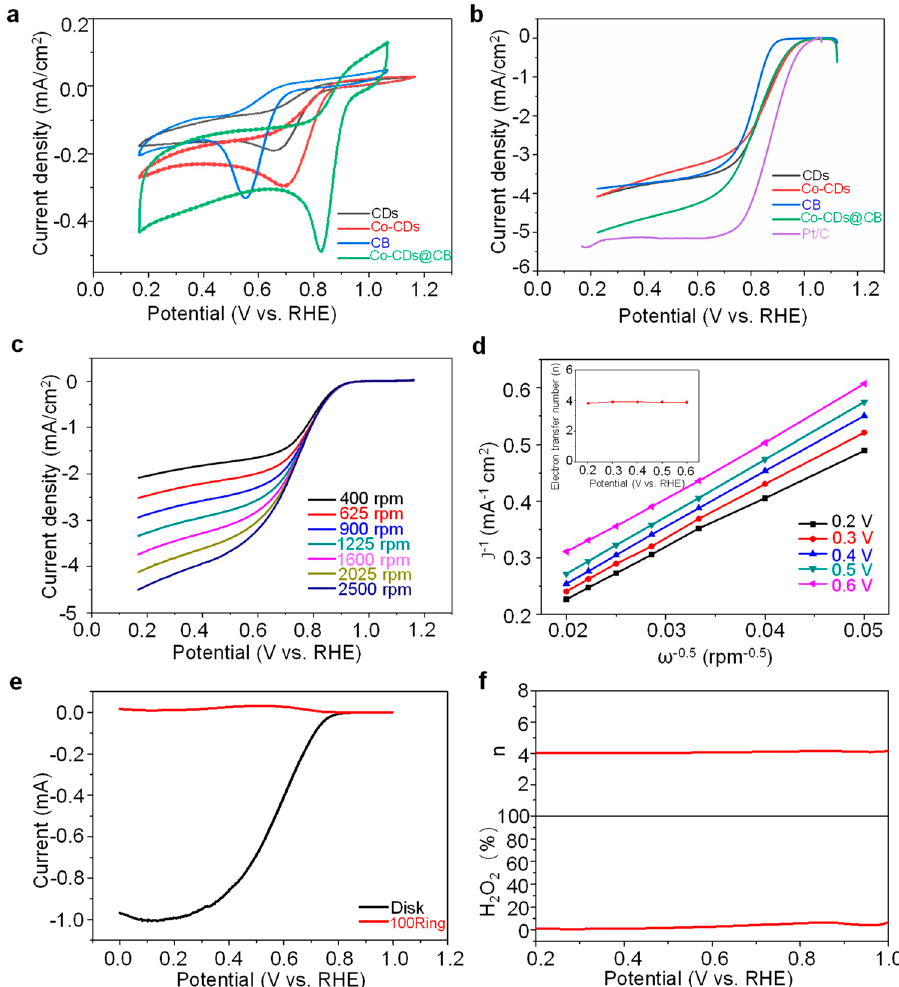
Figure 3. ( a ) CV curves of CDs, Co-CDs, CB, and Co-CDs@CB in O 2 -saturated 0.1 M KOH solution. ( b ) Polarization curves of CDs, Co-CDs, CB, Co-CDs@CB, and Pt/C in O 2 -saturated 0.1 M KOH solution at a rotating rate of 1600 rpm. ( c ) Polarization curves of Co-CDs@CB at different rotation rates. ( d ) K–L plots of Co-CDs@CB (inset: corresponding electron transfer number n of Co-CDs@CB). ( e ) ORR polarization curves using the RDE at a rotating rate of 1600 rpm. ( f ) The peroxide percentage and electron number of Co-CDs@CB. All potentials are without iR compensation.